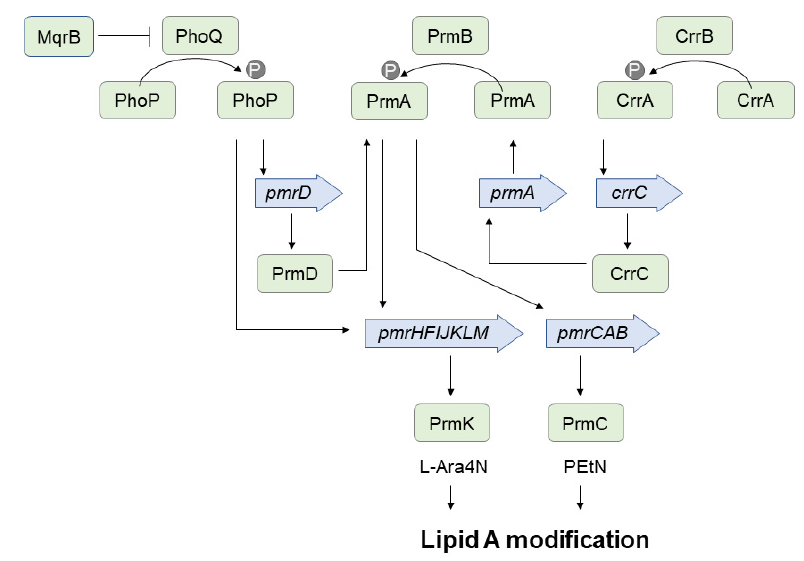
Figure 2. Two-component systems PhoPQ, PmrAB, and CrrAB control lipid A modifications by adding 4-amino-4-deoxy-l-arabinose (L-Ara4N) and phosphoethanolamine (PEtN). The modifications decrease the net negative charge of the lipid A, resulting in colistin resistance. See the text for more details.